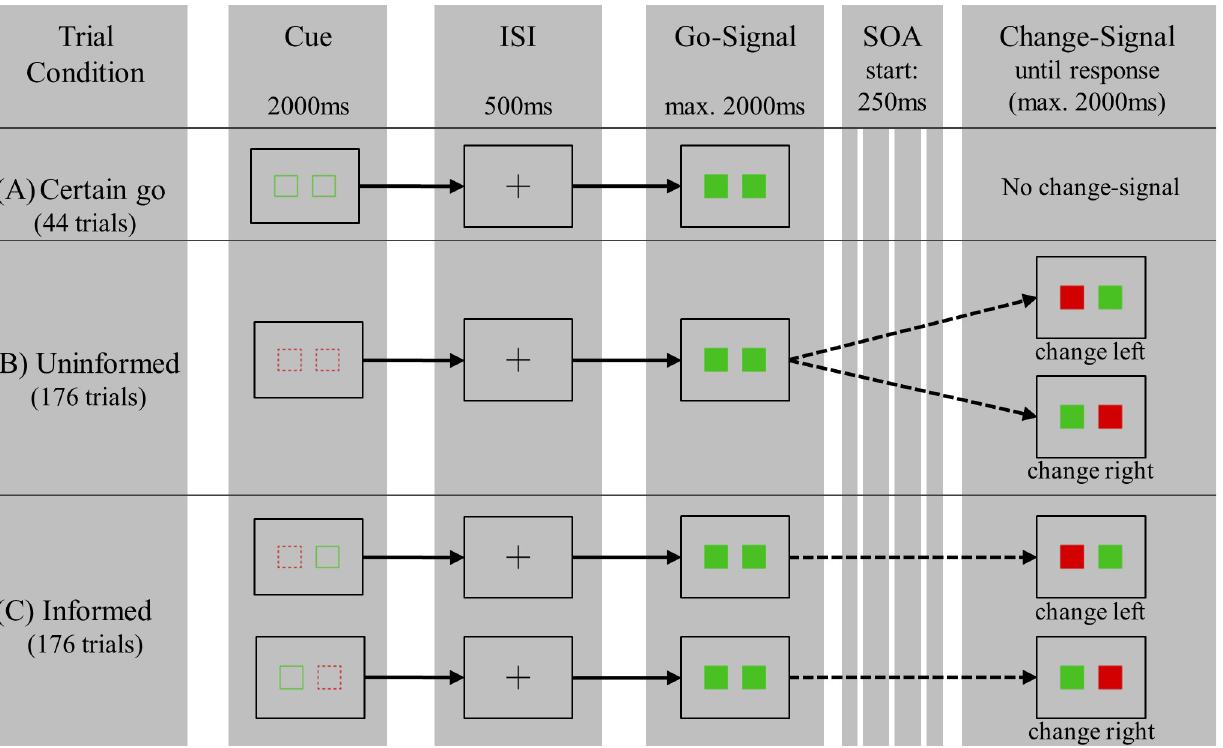
Fig 1. Schematic overview of trial types and conditions in the stop-change task. In the schematic overview each computer screen is represented by a rectangle. The stop-change task consisted of go- and change-trials. In go-trials participants had to respond to the go-signal (two green squares) by pressing simultaneously two corresponding buttons with the index fingers of each hand as fast as possible. In change-trials, after a variable stimulus onset asynchrony (SOA) a change signal (a green and a red squares) was presented after the go signal (two green squares). Depending on the location of the red square participants had to stop pressing the corresponding button with their right or left index finger and should use their middle finger of the right or left hand instead. Go- and change-trials were presented in a mixed design within three foreknowledge conditions. In the certain go condition (A) participants were informed by two green square frames that in the following trial no change signal will appear. In the uninformed condition (B) they were informed by two dashed red square frames that no information was available on which side a change-signal could follow the go-signal. In the informed condition (C) they were informed by a dashed red square frame on which side a change-trial could follow the go-signal. The side of the dashed red square frame corresponds with the hand where the response with index finger has to be stopped and where the middle finger should be used to press the button. ISI = inter-stimulus interval; SOA = stimulus onset